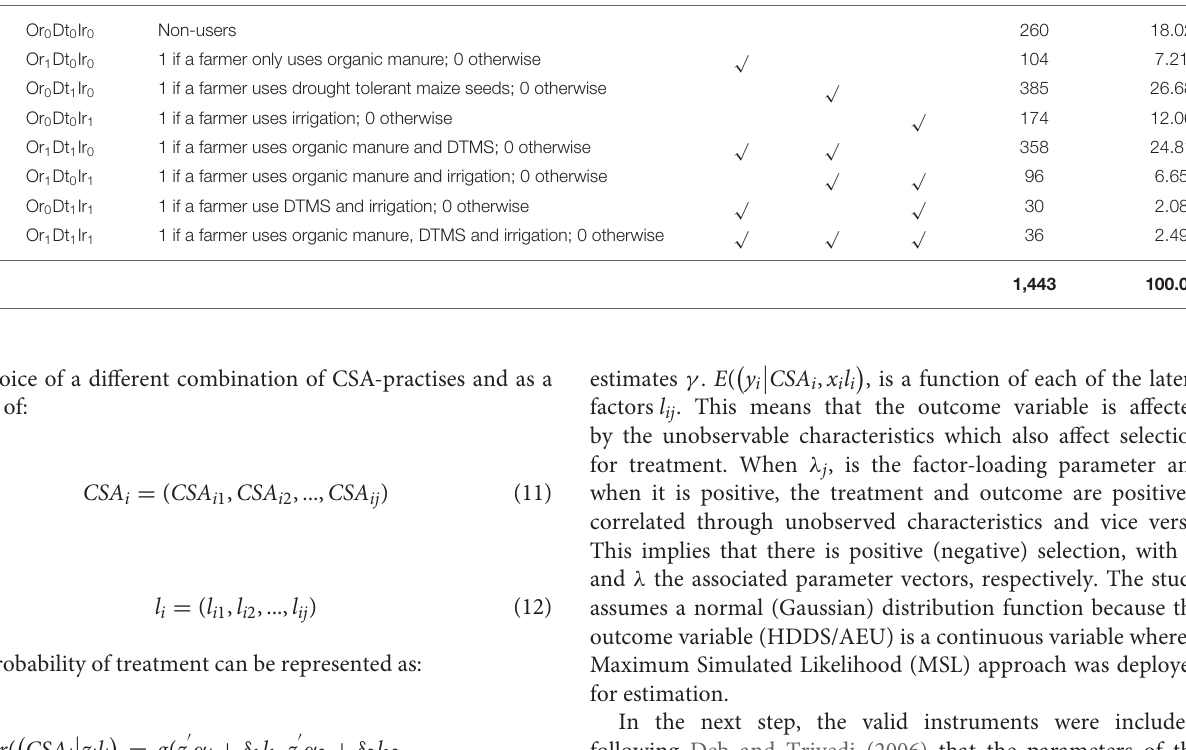
TABLE 1 | Combination of the usage of organic manure, drought tolerant maize seeds, and irrigation. SN